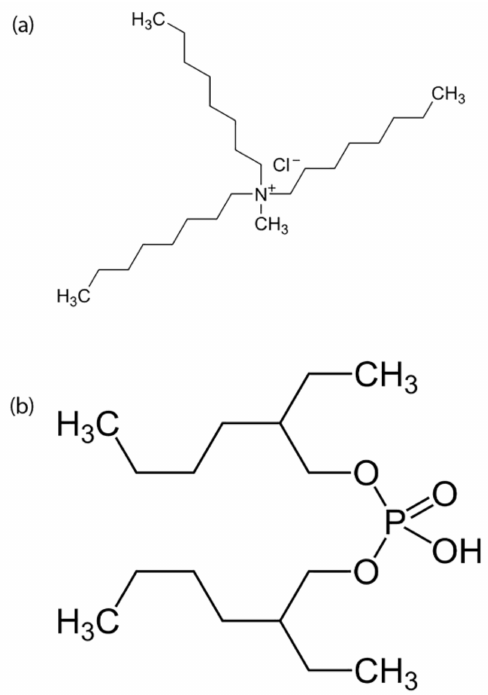
Figure 1. The structures of ( a ) Trioctylmethyl ammonium chloride (A336) and ( b ) bis(2-ethylhexyl) phosphate